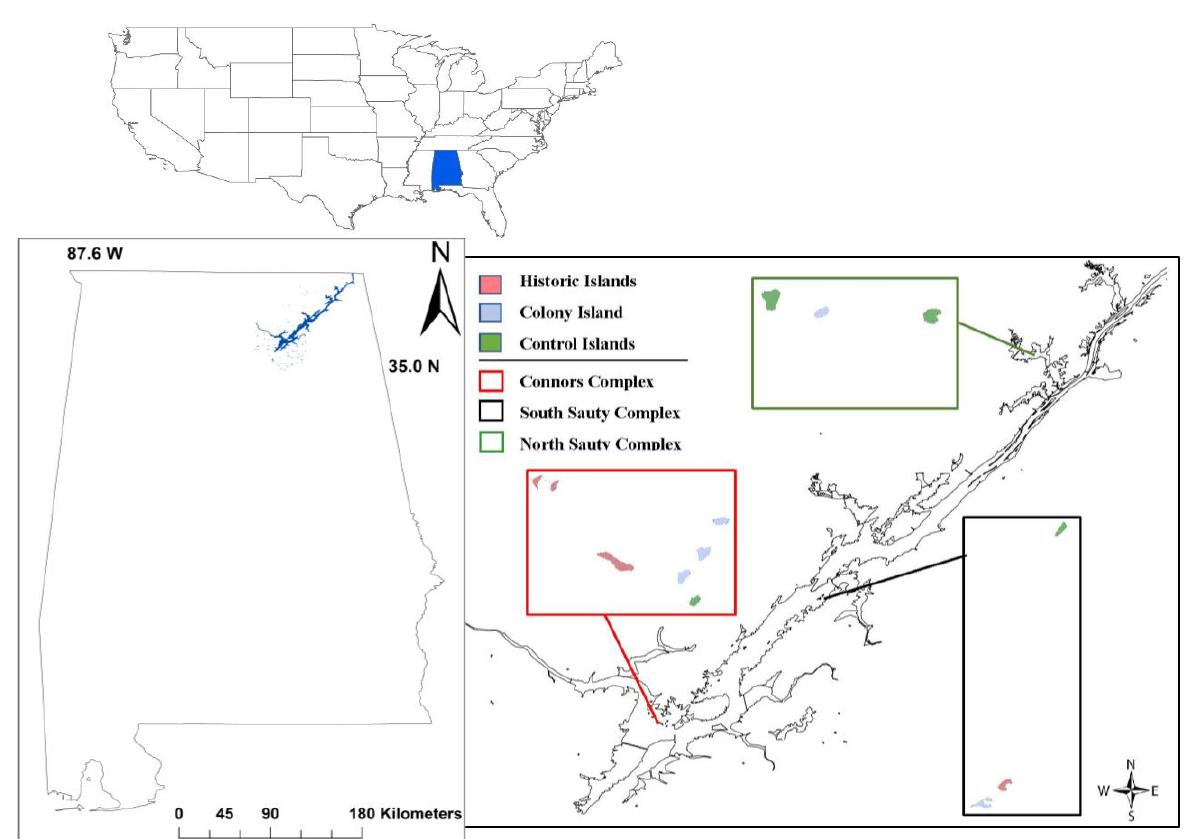
Figure 1. Guntersville Reservoir within Alabama with map at right showing islands colonized, abandoned, and not used by nesting Double-crested Cormorants during March–August 2017.